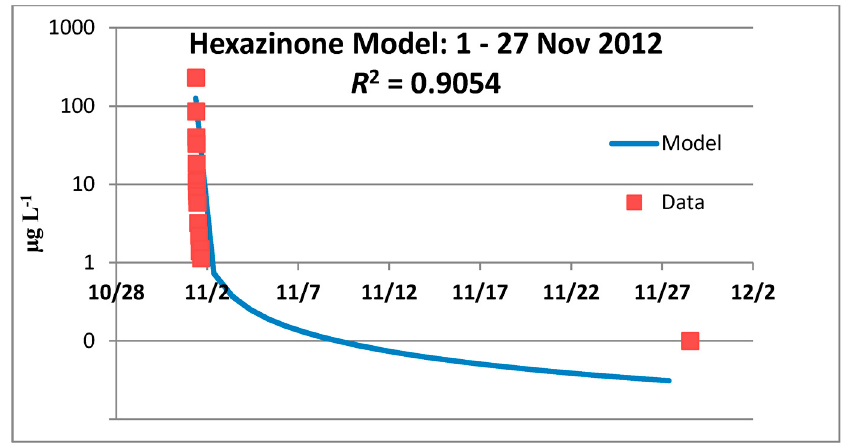
Figure 5. Streamflow hexazinone residue decay curve regression for Year 1 based on data from the sub ‐ catchment trial [30]. Water 2016 , 8 , 573 10 of 24